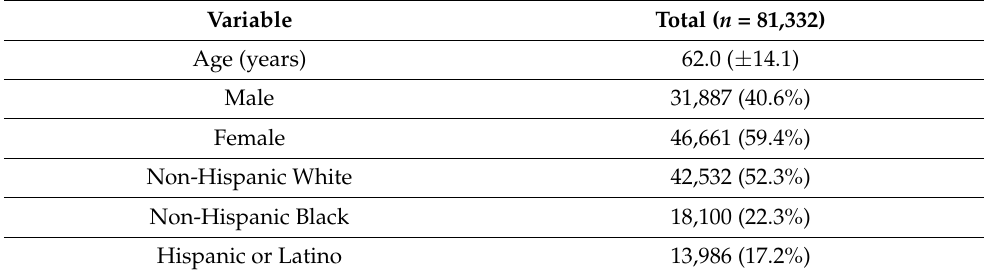
Table 1. Demographic characteristics of participants with Type 2